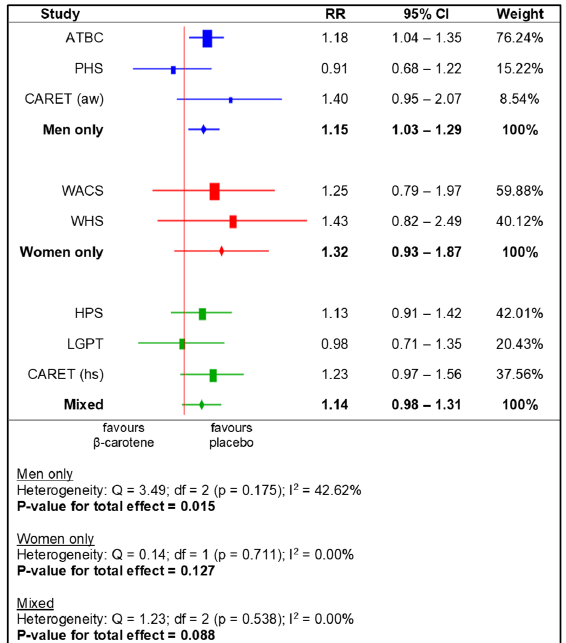
Figure 5. Meta-analysis for subgroups (sex)—lung cancer incidence depending on beta-carotene